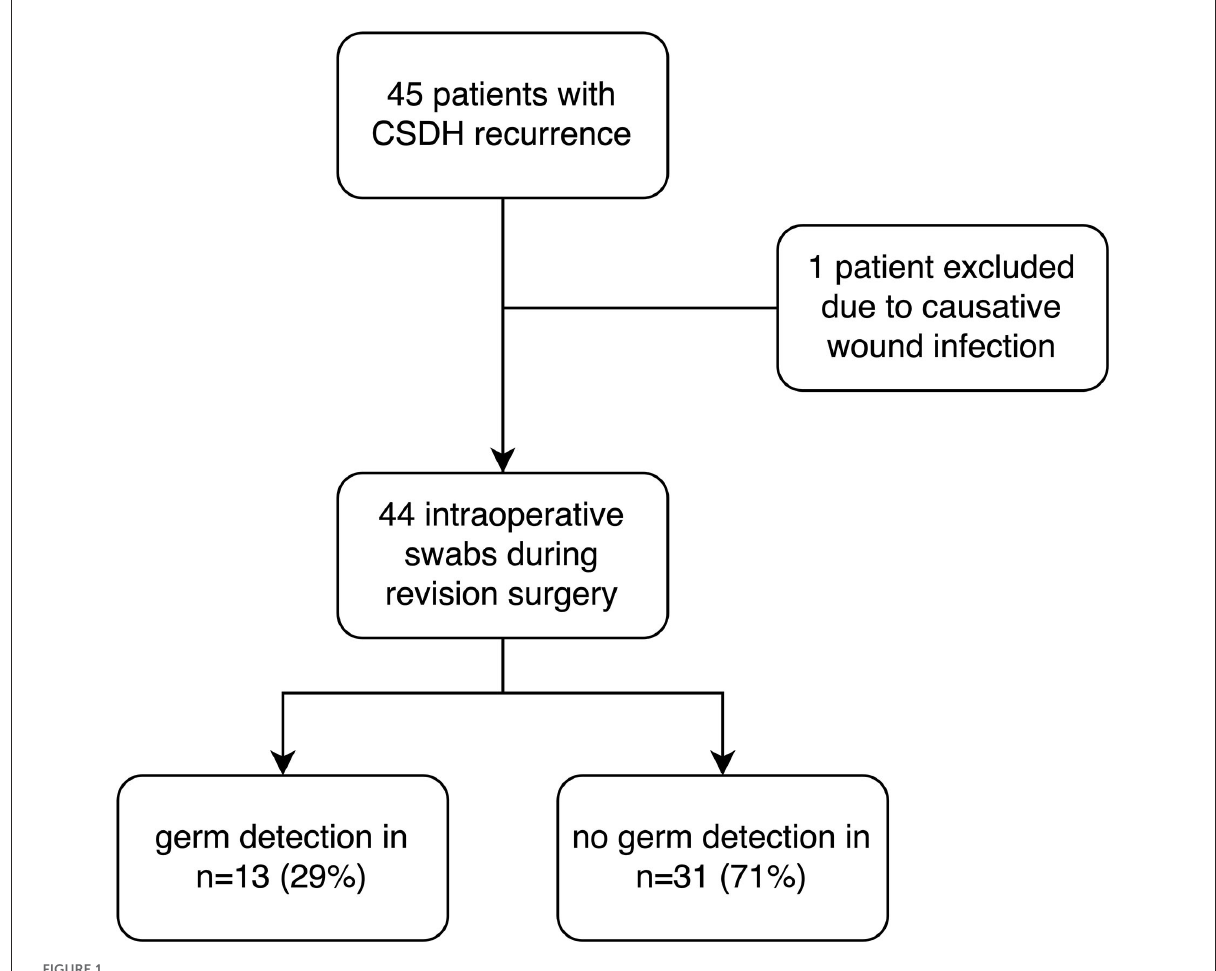
FIGURE1 Study allocation with the illustration of the study